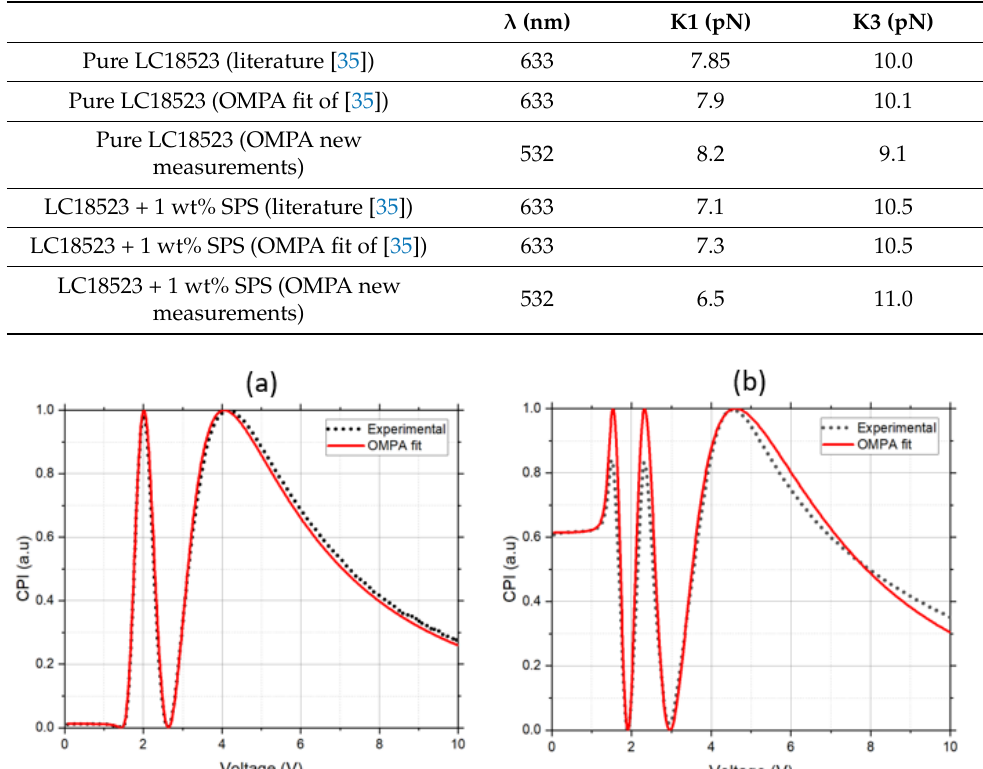
Figure 4. Experimental CPI measurements (black dots) and corresponding OMPA fit (solid red line) of LC18523 + 1 wt% SPS at 633 nm ( a ) and 532 nm ( b ) at 10 kHz. The CPI data fitted at 633 nm ( a ) was collected and published previously [35], and the CPI data fitted at 532 nm ( b ) were measured recently. The fitted parameters that correspond to these fits are presented in Table 2.